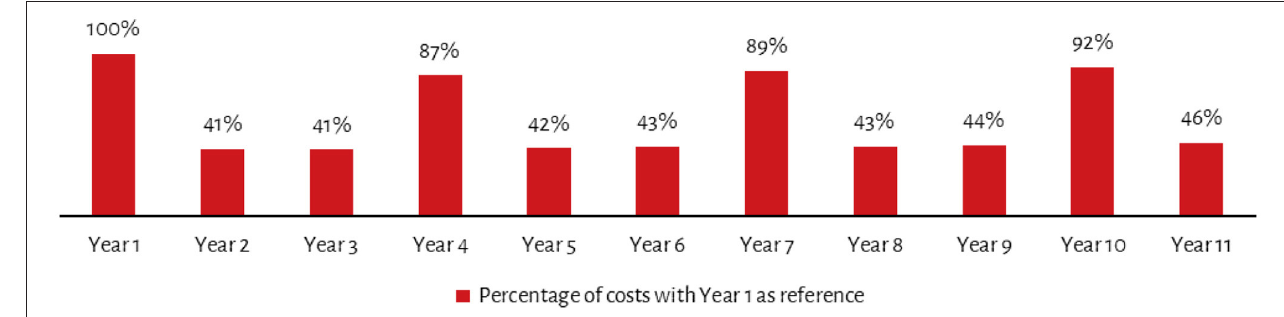
FIGURE 2 | Year-wise costs as a proportion of year 1